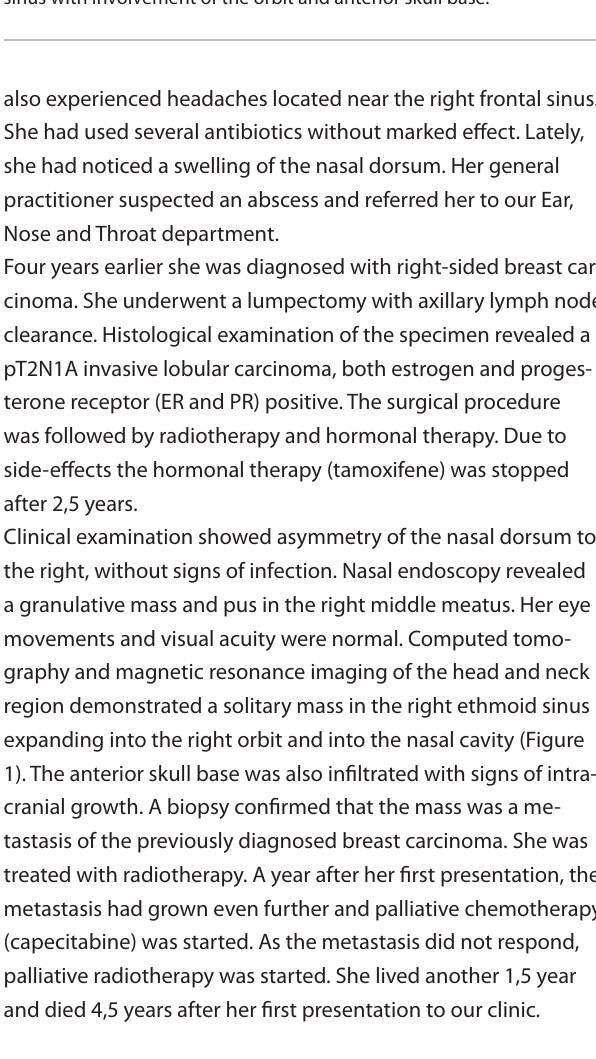
Figure 1. Coronal section of CT scan showing a mass in the right ethmoid sinus with involvement of the orbit and anterior skull base.